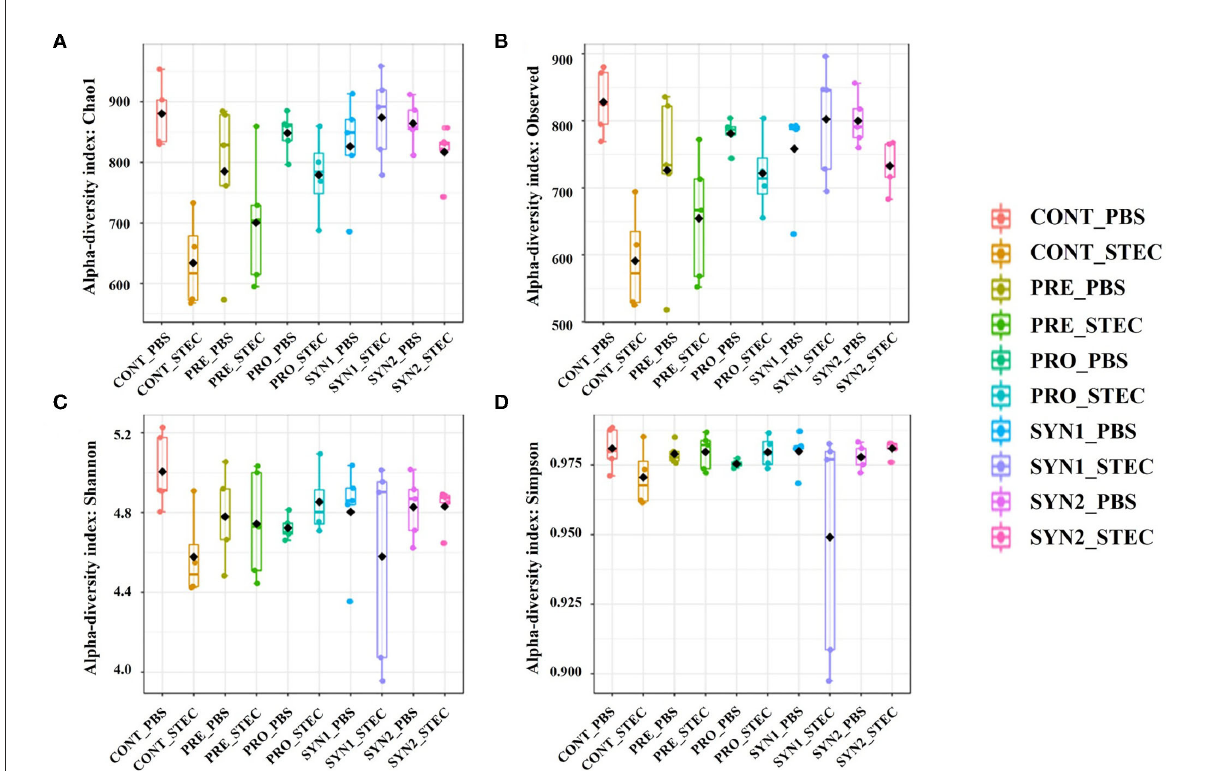
FIGURE1 Box plots showing the alpha diversity indices of the pig groups PRE, PRO, SYN1 and SYN2 with or without STEC challenge. Species richness was measured using (A) Chao1 index and (B) number of observed OTUs, while species diversity was measured using (C) Shannon and (D) Simpson diversity indices. Boxes represent the interquartile range (IQR) between the 25th and 75th percentile, and the black dot inside the box denotes the median value. Whiskers represent the lowest and highest values within 1.5 time from the 25th and 75th quartiles, respectively. Boxes were colored according to treatment group (CONT, PRE, PRO, SYN1, SYN2) challenged with STEC or